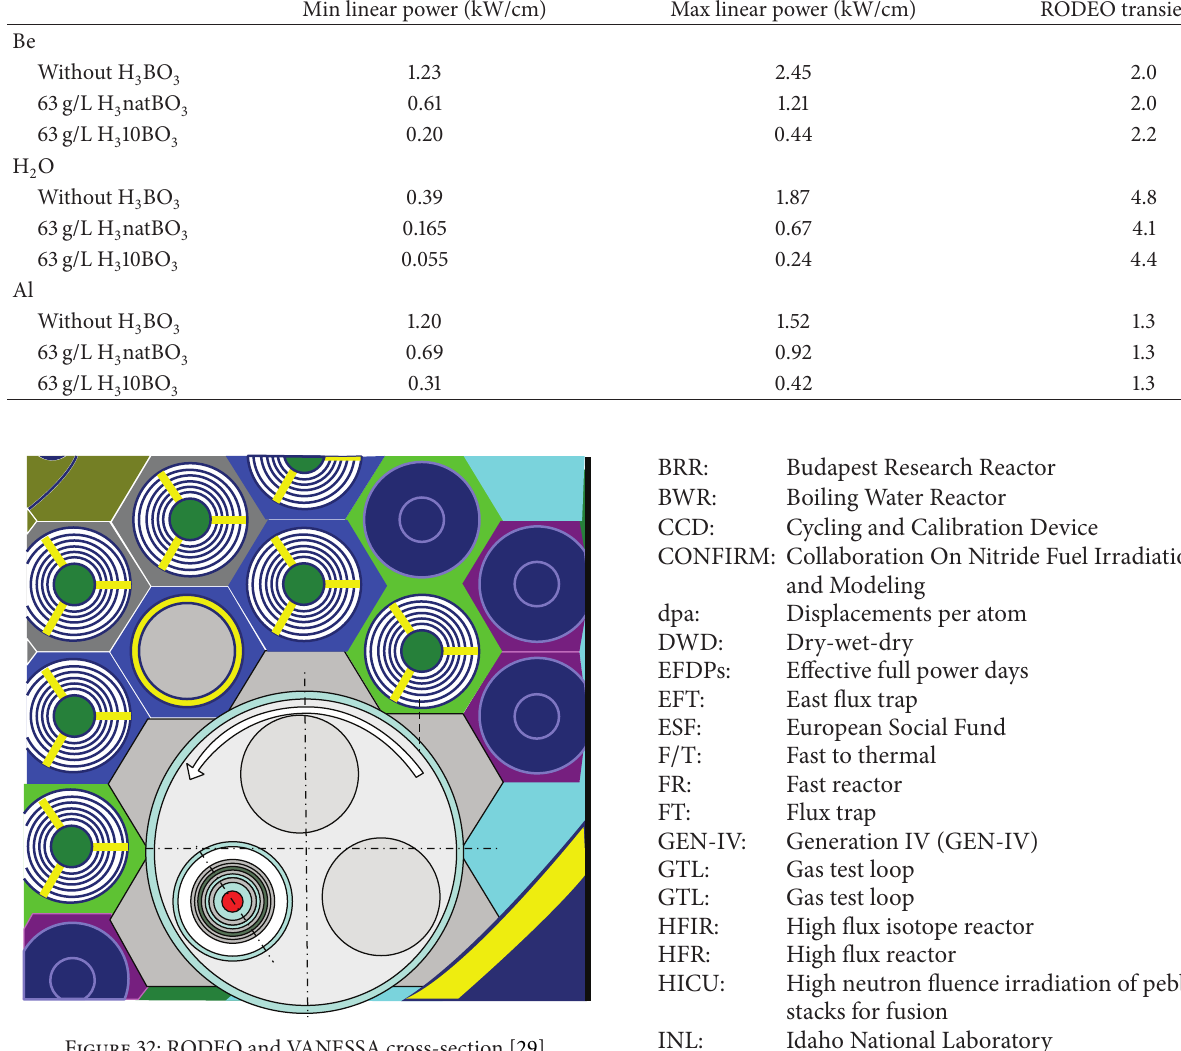
Figure 32: RODEO and VANESSA cross-section